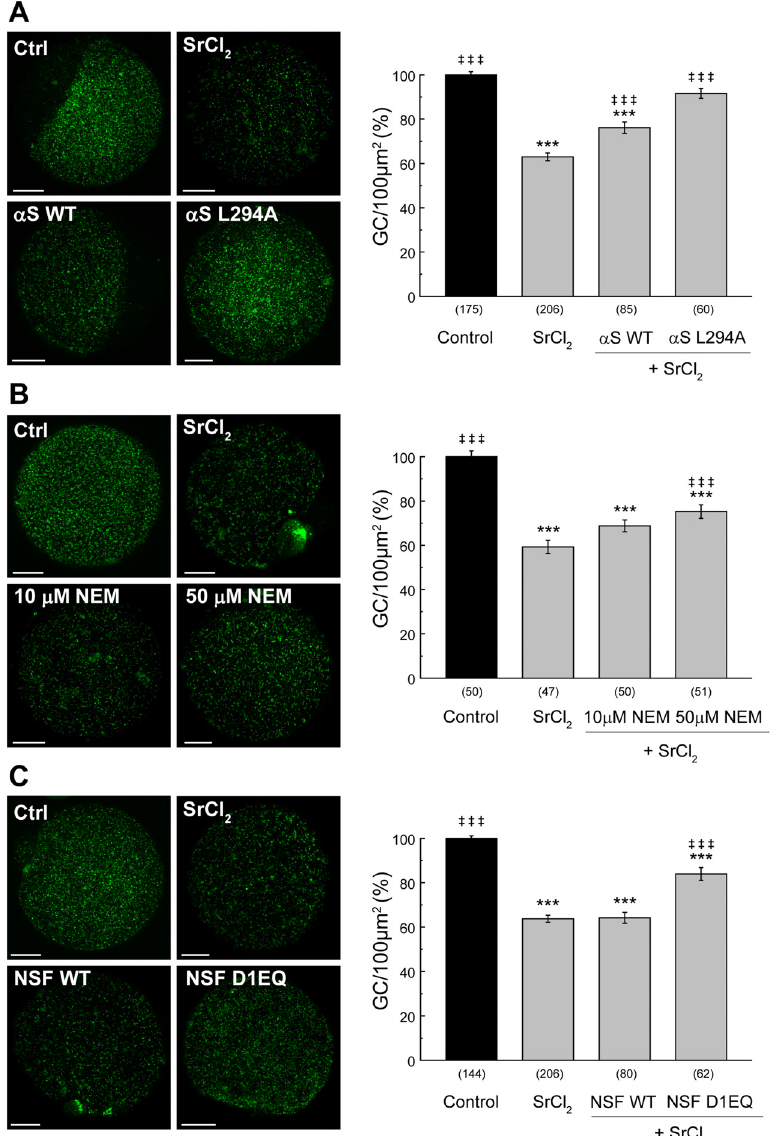
Fig 5. Effect of recombinant wild type α -SNAP, mutant α -SNAP L294A, NEM, wild type NSFand mutant NSF D1EQ and on CGE. A . MII oocytes were microinjected with wild type α -SNAP ( α S WT) or mutant α - SNAP L294A ( α S L294A) prior to CGE activation with 30 mM strontium chloride (SrCl 2 ). Left , representative images of MII oocytes stained with FITC-LCA to label cortical granules. Right , histogram showing % CG density/100 μ m 2 relative to untreated group (Control) set as 100%. Data are shown as mean ± SEM from at least 5 independent experiments; numbers in parentheses represent total number of MII oocytes. *** , values compared to control, p (cid:1) 0.001; ‡ ‡ ‡ , values compared to SrCl 2 , p (cid:1) 0.001. Scale bar: 20 μ m. B . MII oocytes were incubated in presence of different NEM concentrations prior to CGE activated by strontium chloride (SrCl 2 ). Histogram shows % CG density/100 μ m 2 relative to untreated group (Control) set as 100%. Data are shown as mean ± SEM from at least 5 independent experiments. C . MII oocytes were microinjected with wild type NSF (NSF WT) or mutant NSF D1EQ (NSF D1EQ) prior to CGE activation with 30 mM strontium chloride (SrCl 2 ). Left , representative images of MII oocytes stained with FITC-LCA to label cortical granules. Right , histogram showing % CG density/100 μ m 2 relative to untreated group (Control) set as 100%. Data are shown as mean ± SEM from at least 5 independent experiments; numbers in parentheses below bars represent total number of oocytes. *** , values compared to control, p (cid:1) 0.001; ‡ ‡ ‡ , values compared to SrCl 2 , p (cid:1) 0.001. Scale bar: 20 μ